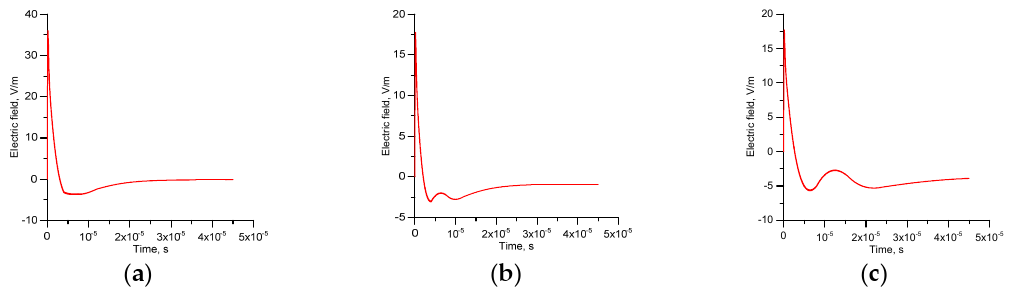
Figure 17 . ( a ) Electric field at 10 km corresponding to the example shown in Figure 8b; ( b ) electric field at 5 km corresponding to the example shown in Figure 8b; ( c ) electric field at 5 km when the decay time constant of the growth curve is increased from 4 μ s to 8 μ s.